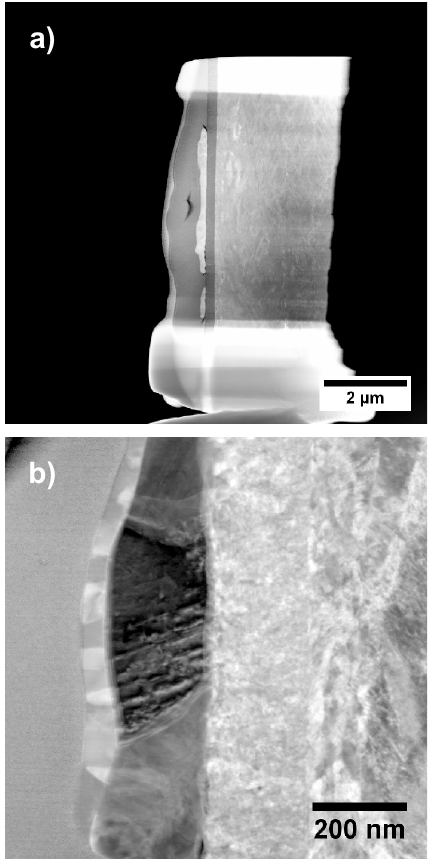
Figure 16. ( a ) STEM HAADF Overview image of sample “Au/Pt”. The layer structure consisting of different elements is easily seen due to the Z-contrast in the micrograph; ( b ) STEM DF detail image of a catalyst particle on the support. The different layers are (right to left): stainless steel, Ti, Ru, Zr, and Pt, which is used in the FIB preparation.